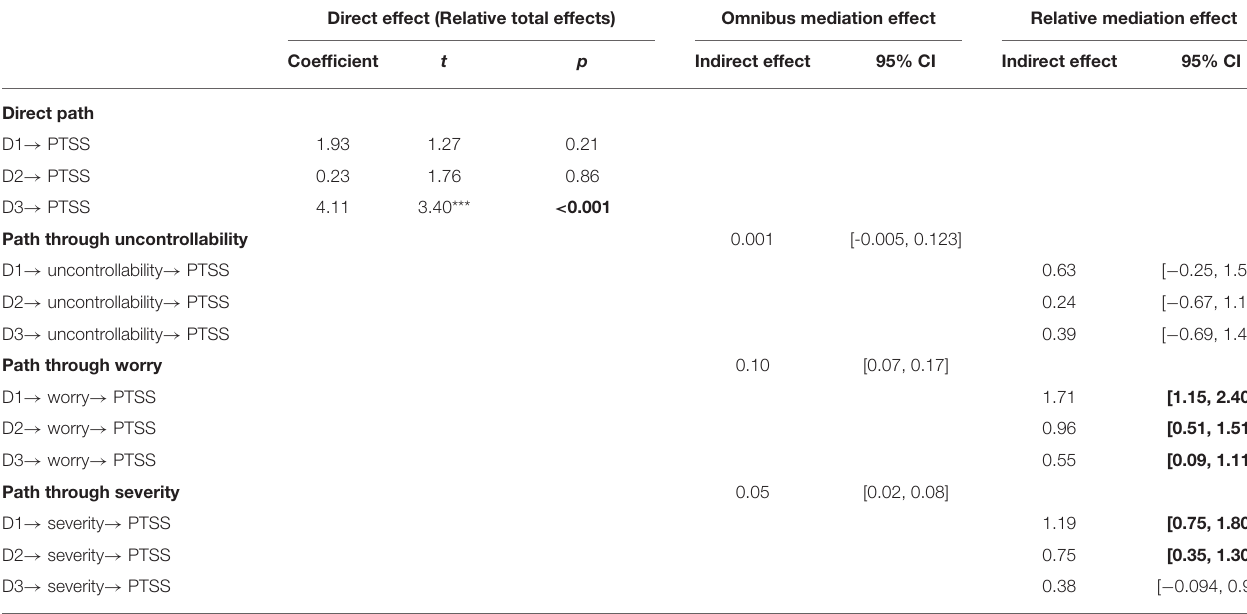
TABLE 4 | Mediating effects of risk perception on the relationship between media exposure and